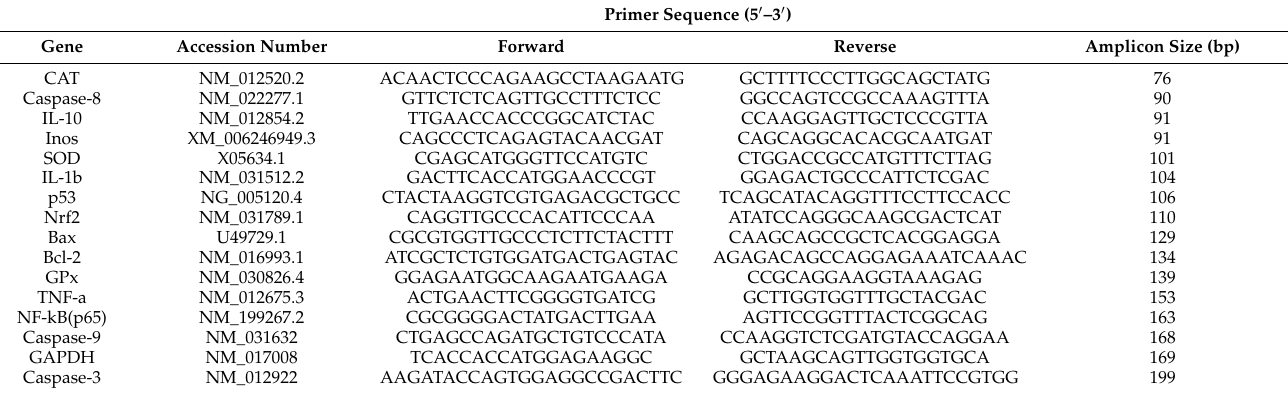
Table 1. Sequence for Primers in tabular form. Primer Sequence (5 (cid:48) –3 (cid:48)